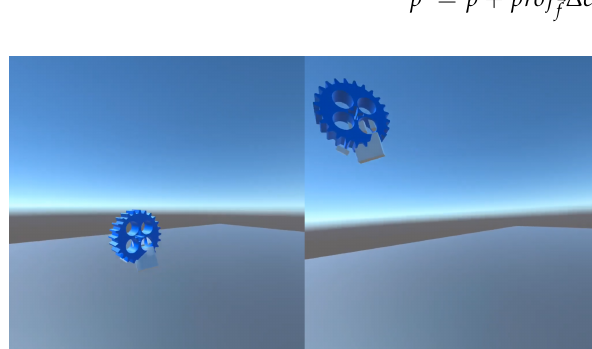
Figure 3. Free translation.